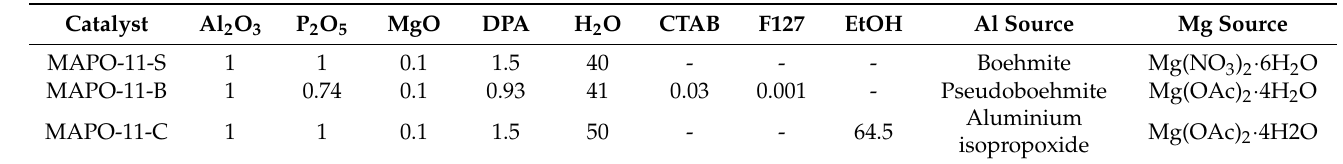
Table 3. Precursor gel molar batch compositions of the different samples of